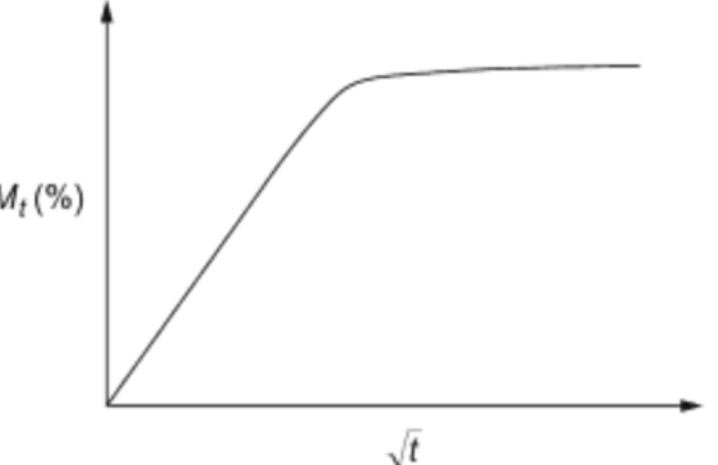
Figure 9. Fickian diffusive curve [137] (reprinted with permission from Elsevier, Licence Number: 5447061247707).